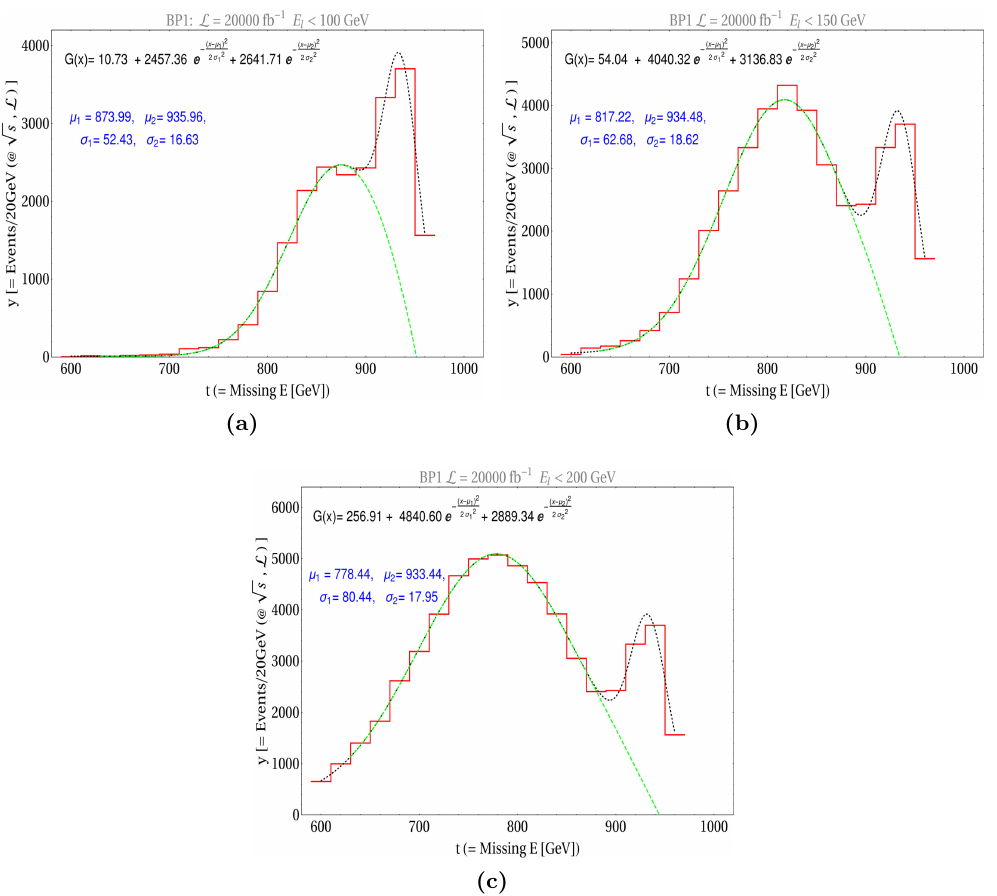
Figure 23. /E distribution and Gaussian fitting for BP1 together with SM background with different cuts on leading lepton energy: (a) E polarization of initial beams is chosen as P3 and L = 20 ab − 1 has been used for